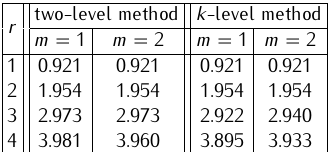
Table 2. Order estimates for combined methods with the two-level and the k -level